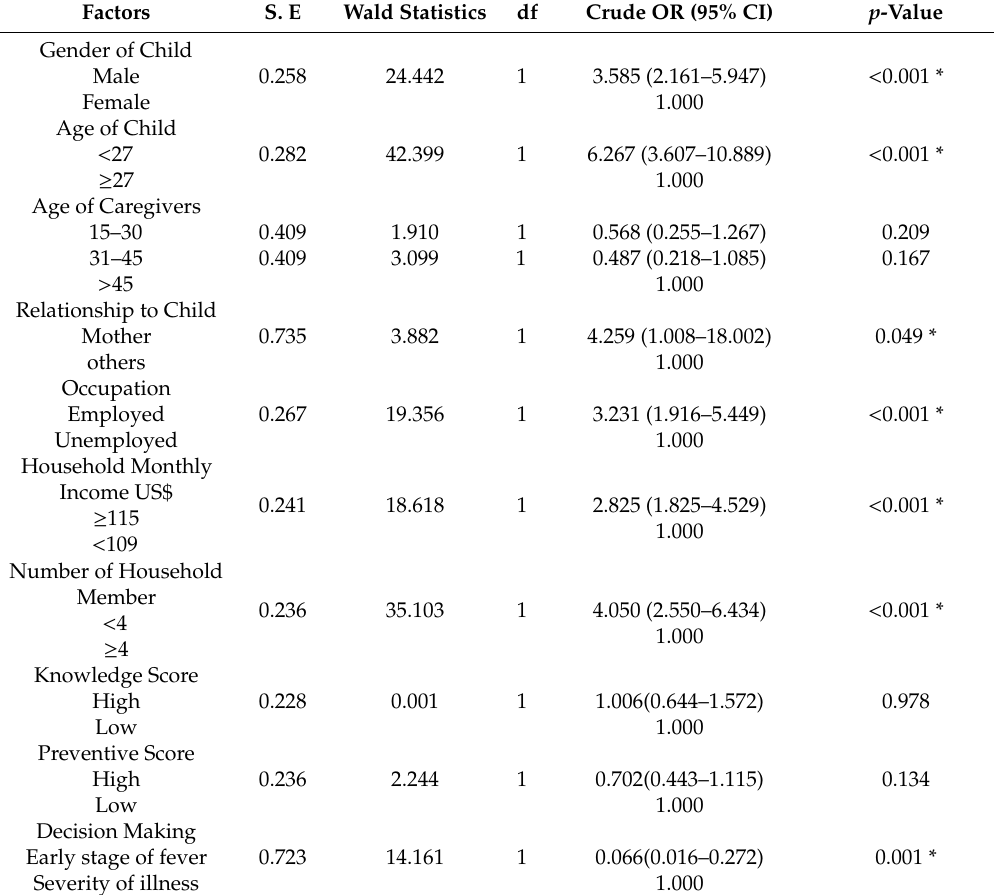
Table 4. Simple logistic regression showing crude odd ratio (OR) of predictors of appropriate health seeking behavior (N =